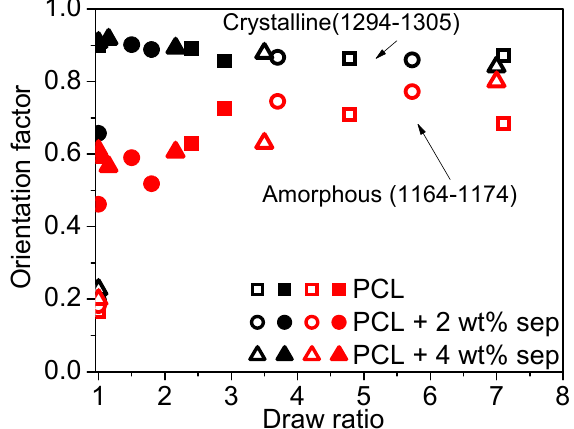
Figure 12. Orientation functions as a function of the draw ratio. The calculations are performed based on C-O vibrations. The open symbols correspond to samples cooled with open chill rolls. The closed symbols to samples cooled with closed chill rolls. The black symbols show the orientation factor associated with the crystalline phase. The red symbols show the orientation factor calculated for the amorphous phase.